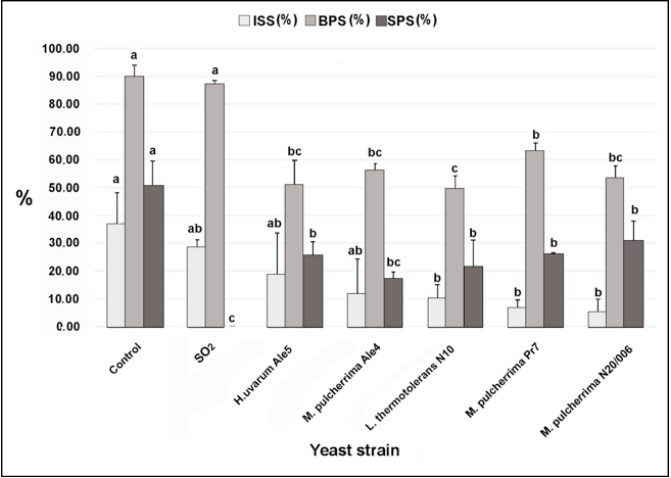
Figure 3. Antagonistic activity of yeast strains in inhibiting gray mold decay on grape berries in semi-commercial conditions. Effects of yeasts refer to the incidence of ‘slip skin’ (ISS), browning of pedicel severity (BPS), and sporulation on pedicel severity (SPS), caused by Botrytis cinerea 30 days after incubation at 0 °C. Data are presented as the mean of three replicates with the standard deviation (vertical bars).